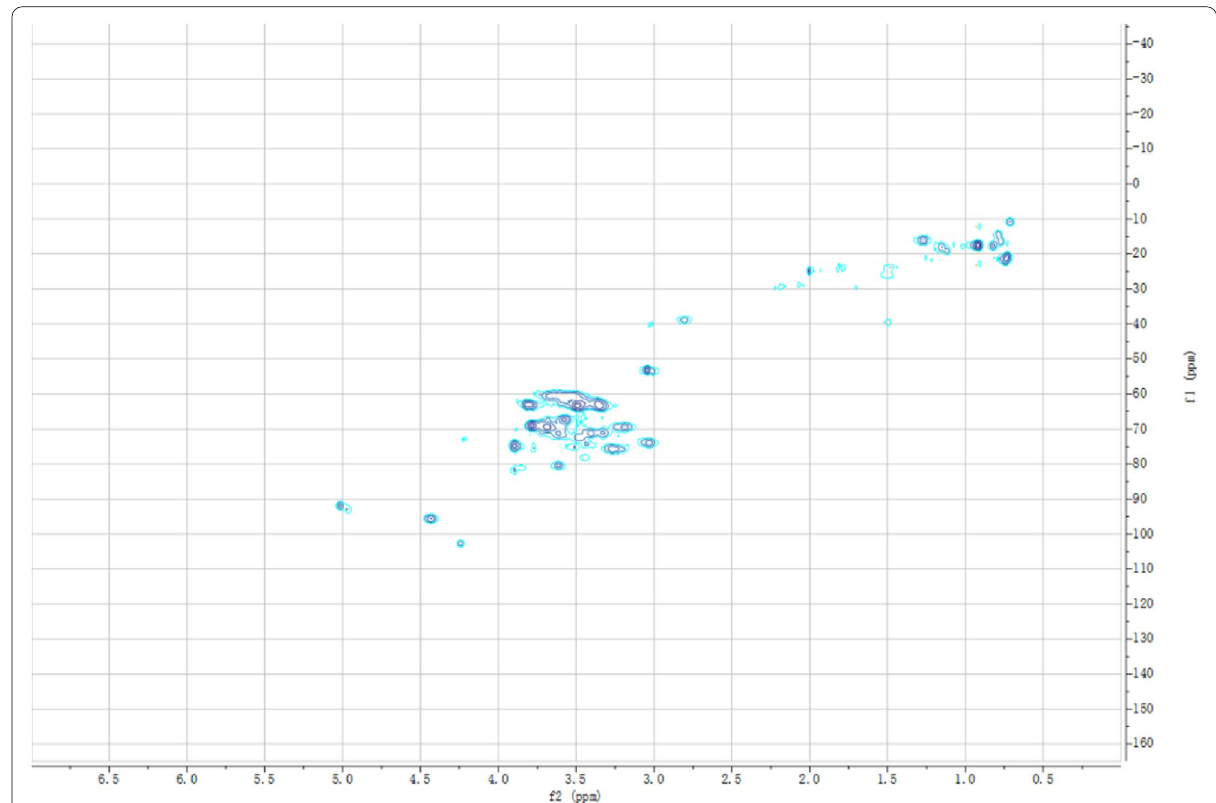
Fig. 5 HSQC analysis of the fermentation supernatant of mixed strains by